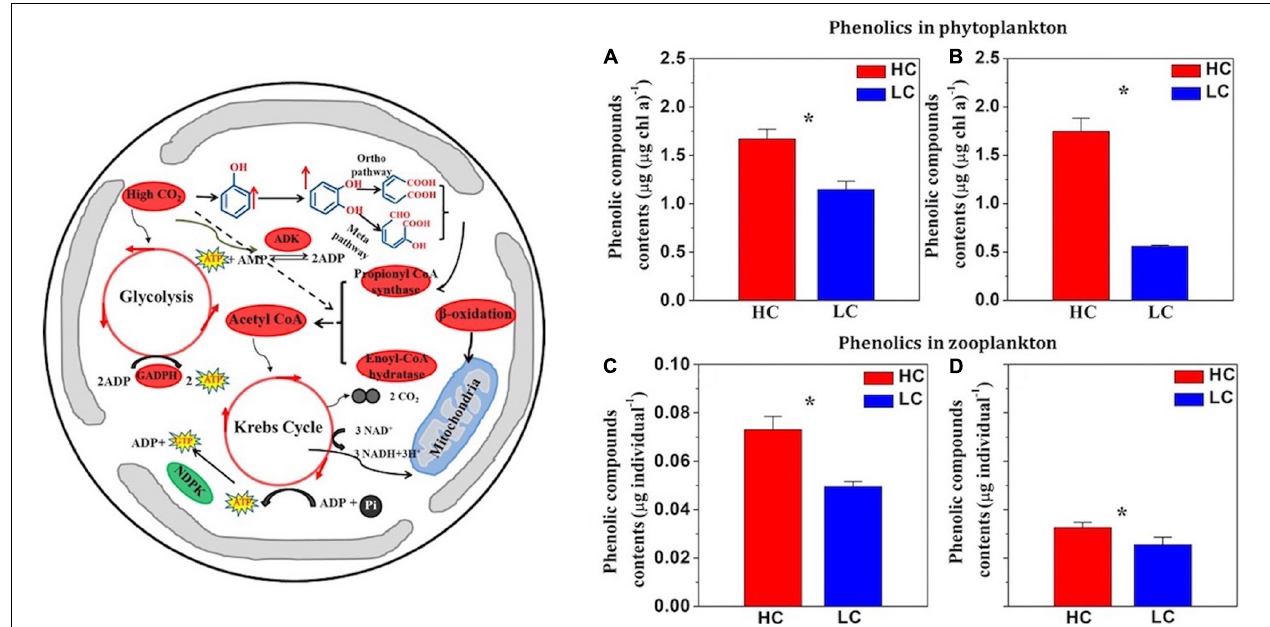
FIGURE 1 | Left panel: Ocean acidification (OA) up regulates (red) or down regulates (green) metabolic pathways of the calcified phytoplankton species Emilianiahuxleyi. The cells up regulate several metabolic pathways such as Îš-oxidation, the TCA cycle, and glycolysis which is required for the degradation of phenolics, in order to gain more energy to resist OA. Right panels: OA significantly increased the concentrations of phenolics of phytoplankton assemblages in 30-L microcosm (A) and in 4000-L mesocosm experiments (B). Content of phenolic compounds (Îijg per individual) in zooplankton assemblages that were fed on high CO2 (HC, 1000 Îijatm, Red bar) or low pCO2 grown (LC, 395 Îijatm, Blue bar) phytoplankton cells collected from the microcosms (C) or mesocosms (D) (Jin et al., 2015). Vertical lines represent standard deviation of the means. *Significance at the p < 0.05 level. (reconstructed from Jin et al.,